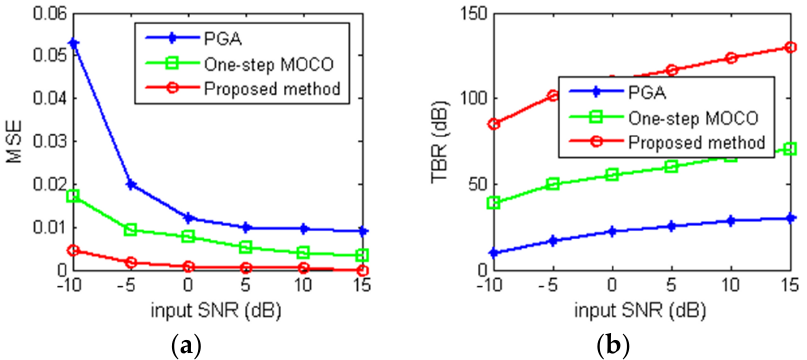
Figure 7. Quantitative evaluation of reconstruction results under various input SNRs. ( a ) MSE results; ( b ) TBR results.